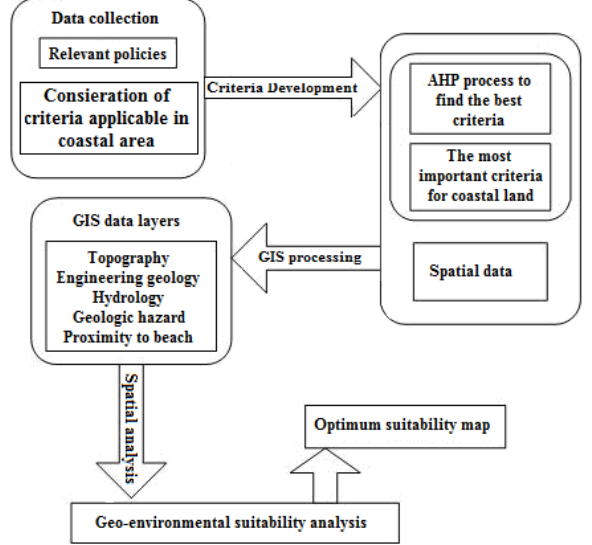
Fig. 3. Methodological framework for this